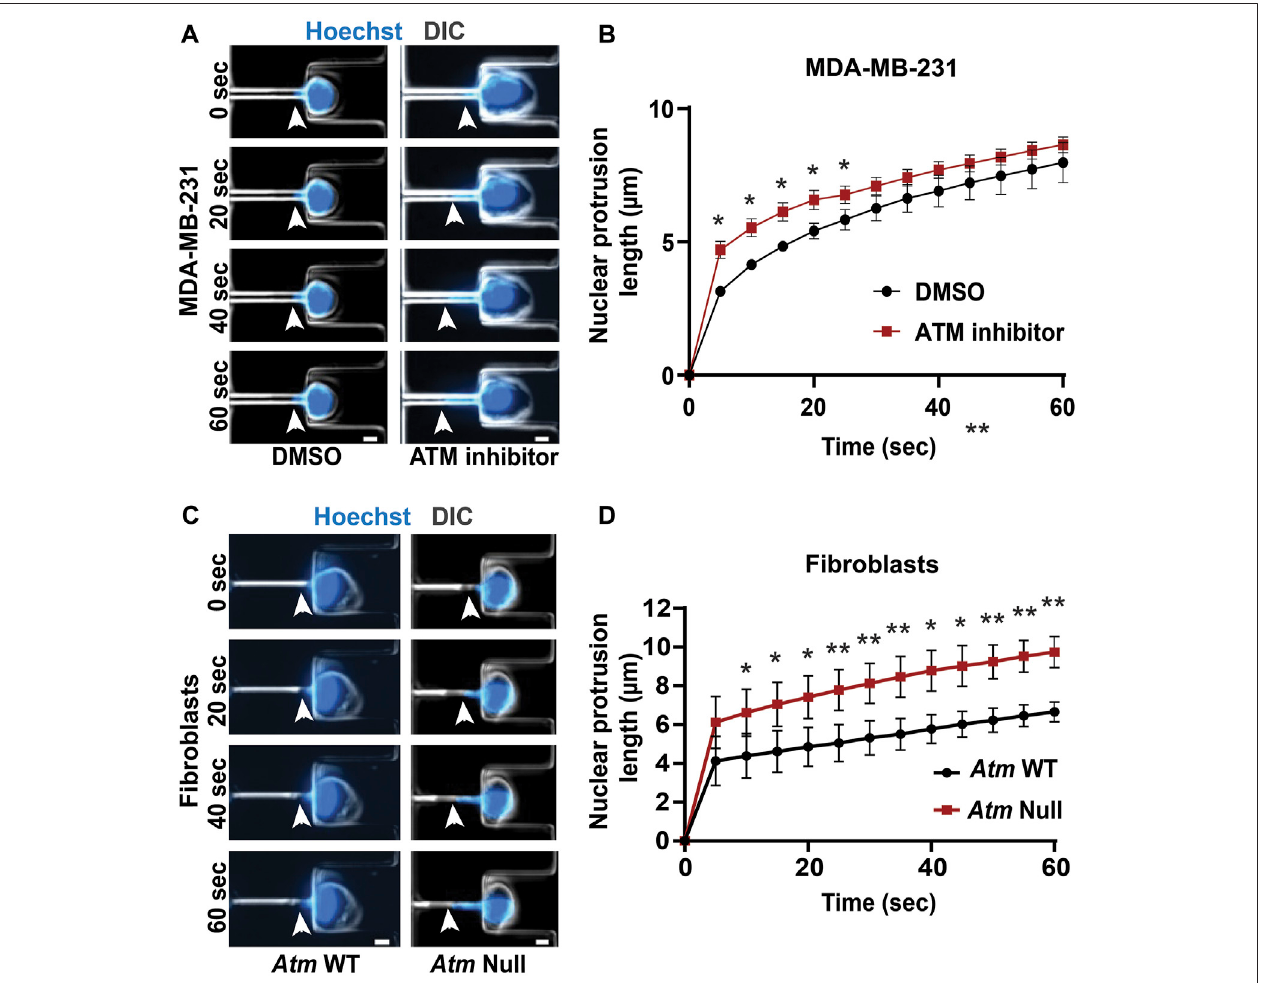
FIGURE4| FunctionallossofATMmakesnucleimoredeformable. (A) Representativetime-lapseimagesequenceofMDA-MB-231cellstreatedwithATMinhibitor KU-55933 ( n = 95 cells) or vehicle control (DMSO, n = 45 cells) undergoing nuclear deformation in micropipette aspiration device with channels of 3 × 5 μ m 2 in size. Arrowheads indicate the leading edge of nuclear protrusion. Scale bar: 5 µm (B) Quanti fi cation of the nuclear protrusion length inside the micropipette aspiration channelsasshownin (A) basedonthemeansofthreeindependentexperiments.*, p < 0.05;basedonpaired t -test, N =3. (C) Representativeimagepanelof Atm - NullMEFs( n =117cells total) and Atm wild-type(WT)controls ( n =130cellstotal) undergoing nuclear deformation inmicropipetteaspirationdevice withchannels of3× 5 μ m 2 in size. Arrowheads indicate the leading edge of nuclear protrusion. Scale bar: 5 µm (D) Quanti fi cation of the nuclear protrusion length inside the micropipette aspirationchannelsasshownin (C) ,basedonthemeansofthreeindependentexperiments.*, p < 0.05;**, p < 0.01;basedonpaired t -test, N =3.Errorbarsinthis fi gure represent mean ± s. e.m. of the mean values of each experiment.